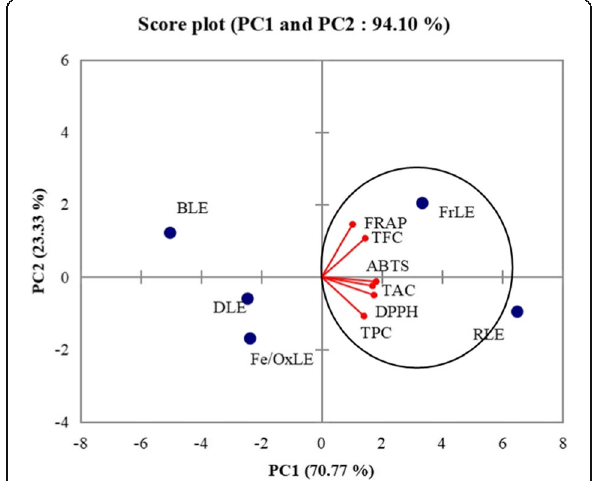
Fig. 5 Score plot showing distribution of extracts relative to antioxidant properties according to PC1 x PC2. PC: principal component; FrLE: fresh leaf extract; RLE: roasted leaf extract; DLE: Dried leaf extract; BLE: Blanched leaf extract; Fe/OxLE: Fermented/ oxidised leaf extract; TAC: total antioxidant capacity; TPC: total